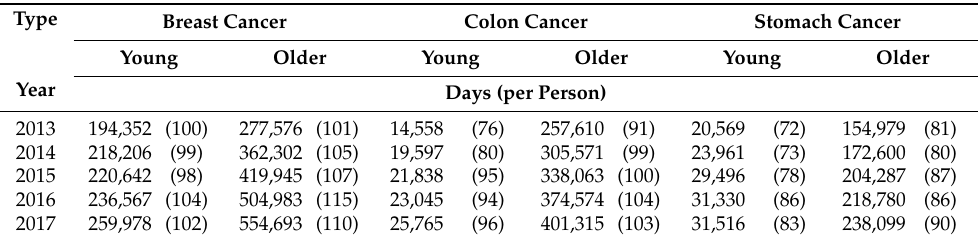
Table 4. Days of medication for women cancer survivors in convalescent hospitals by age group between 2013 and